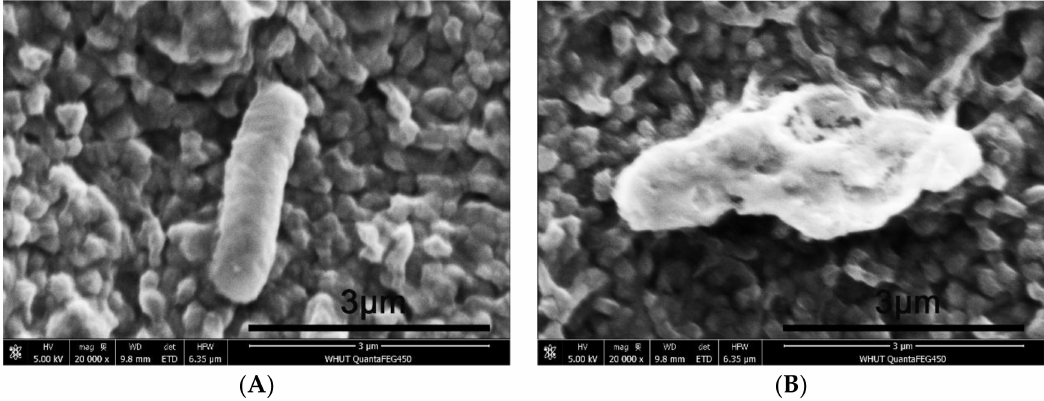
Figure 4. SEM images of the native ( A ) and treated E. coli cells ( B ) with a scale bar (3 µ